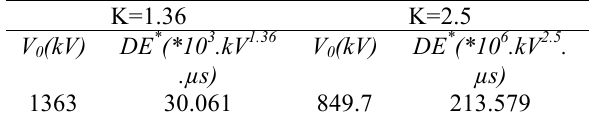
Table 2: The value of Parameters of Integration method in 400-kV